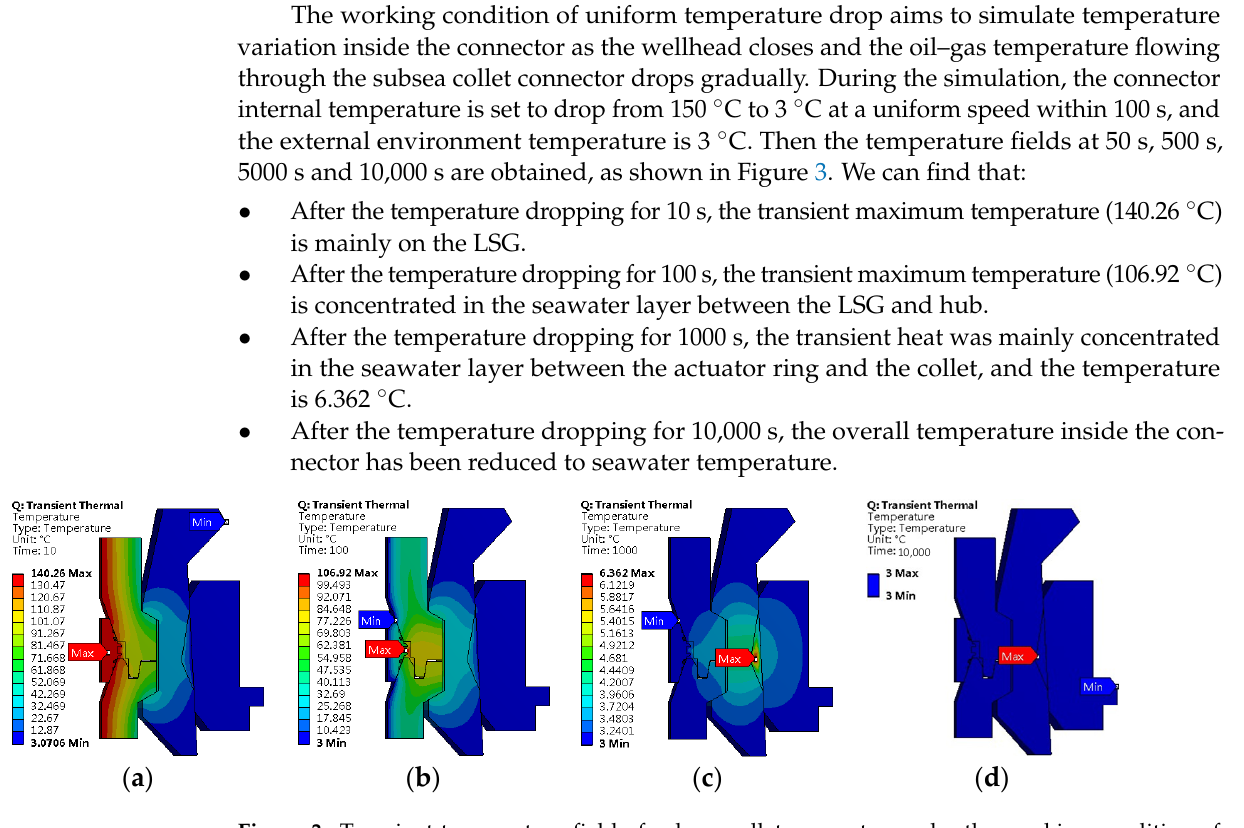
Figure 3. Transient temperature field of subsea collet connector under the working condition of uniform temperature drop. ( a ) 10 s; ( b ) 100 s; ( c ) 1000 s; ( d ) 10,000 s. Table 3. The time required for each component to drop to the seawater temperature under the work- ing condition of uniform temperature drop.